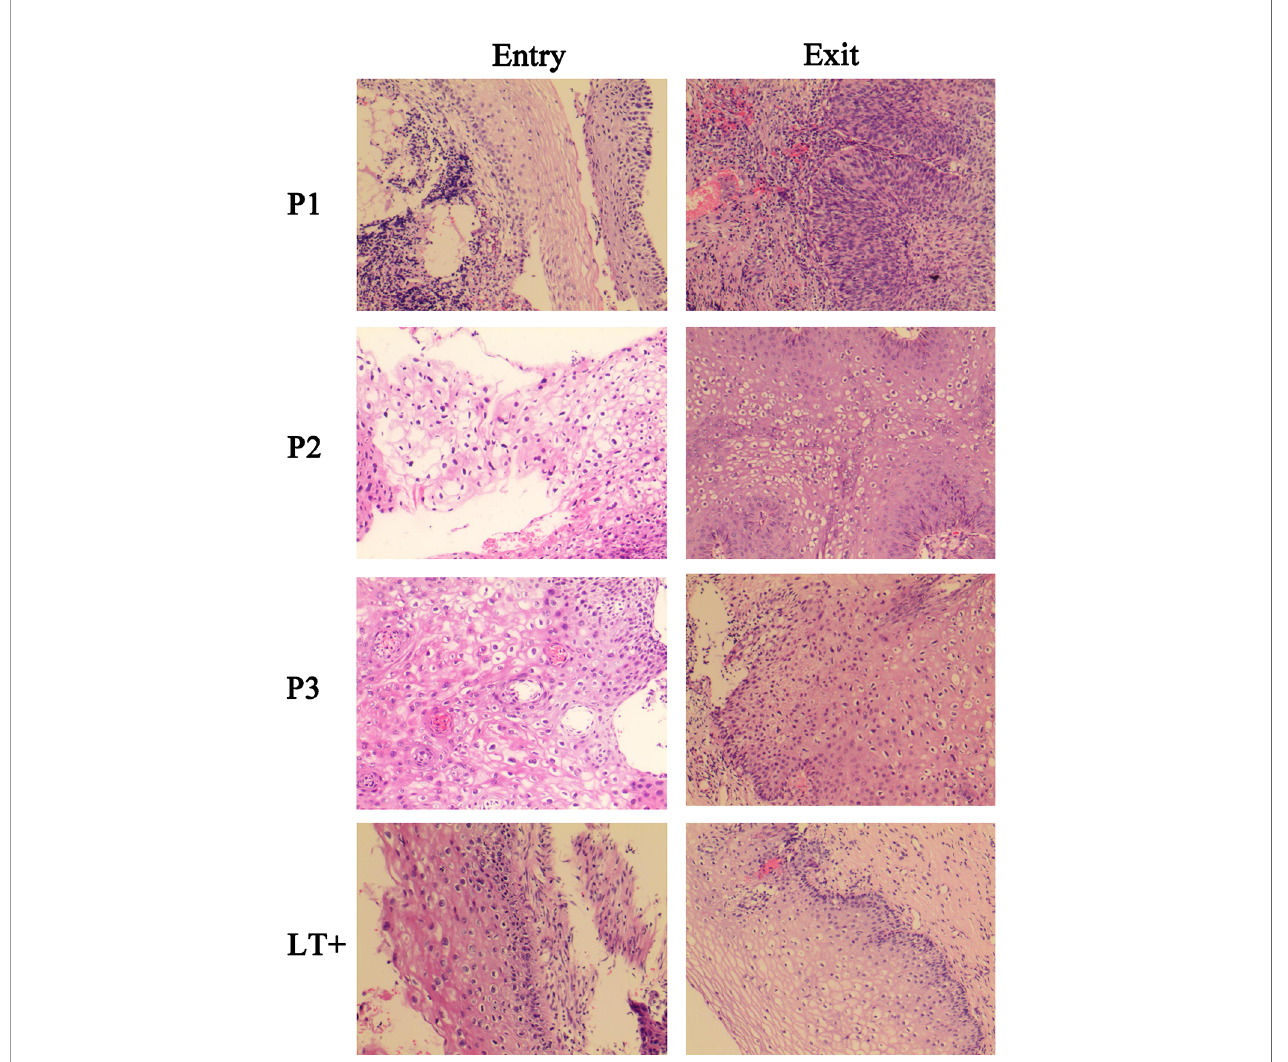
FIGURE 2 | Histological images of three progressed patients and a regressed representative patient. P1, P2, P3, were HPV16-infected patients in NILM cohorts at the study entry. At study exit, P1 progressed to HSIL, and P2, P3 progressed to LSIL. LT+, is a regressed representative of patients positive for the HPV16 E7 speci fi c T lymphocyte response, who was LSIL at study entry and completely regressed at study